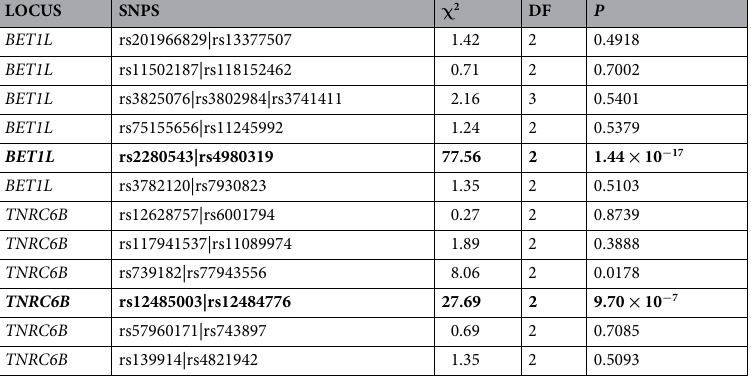
Table 3. Haplotype based genetic associations of BET1L and TNRC6B with UL. DF, degree of freedom. Significant results were highlighted in bold. P value threshold after Bonferroni corrections was 0.05/12 ≈